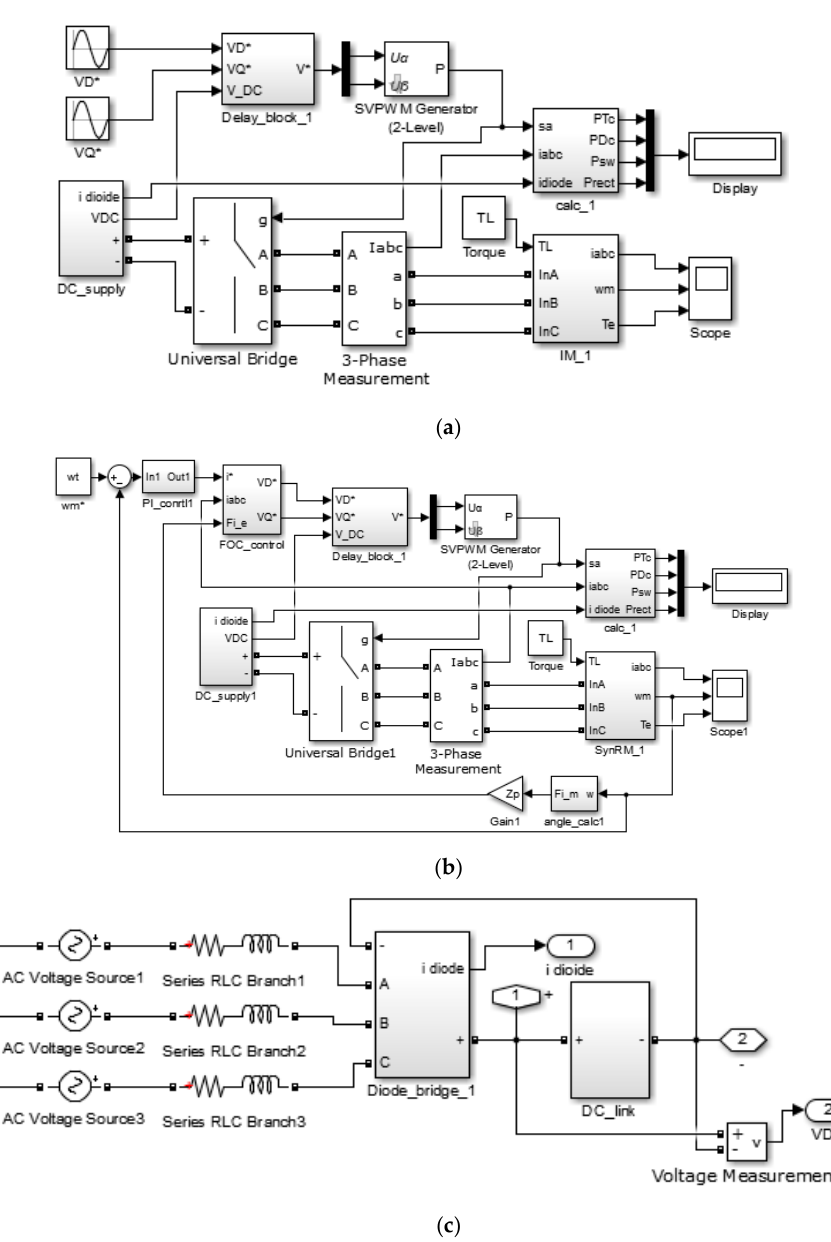
Figure 6. Simulink models. ( a ) CDM with IM; ( b ) CDM with SynRM; ( c ) DC supply block.